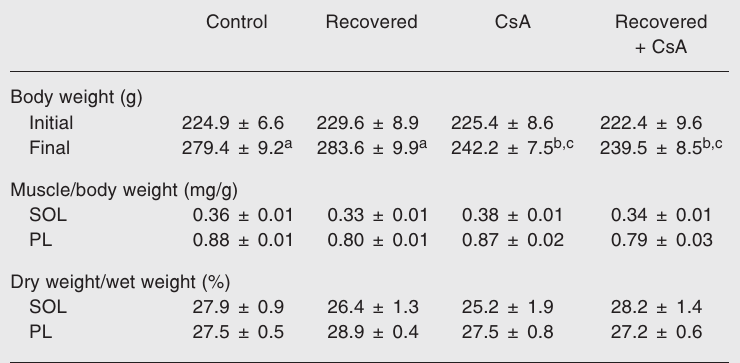
Table 3. Effect of cyclosporin-A (CsA) administration on rat soleus (SOL) and plantaris (PL) muscles during recovery.